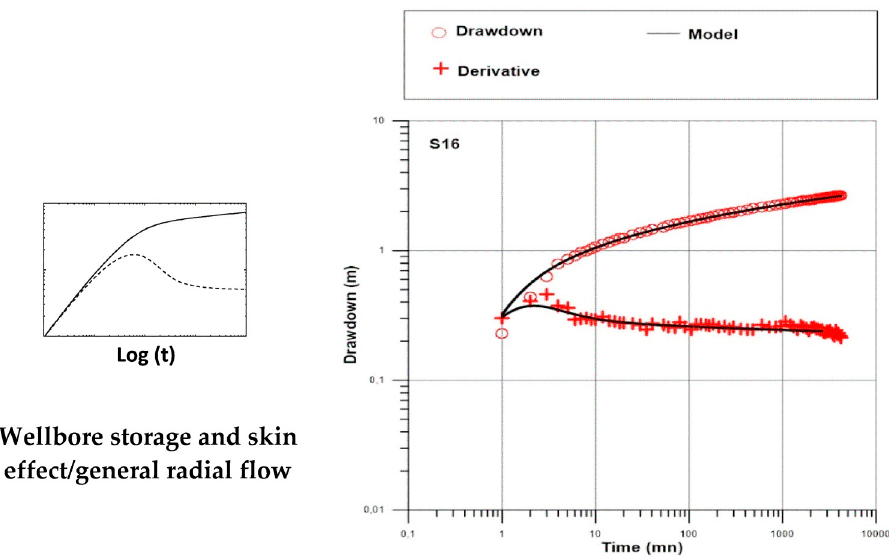
Figure 17. Interpretation of pumping test S15/S16: diagnostic plot ( left ) and data superimposed with a fitted Dougherty-Babu model ( right